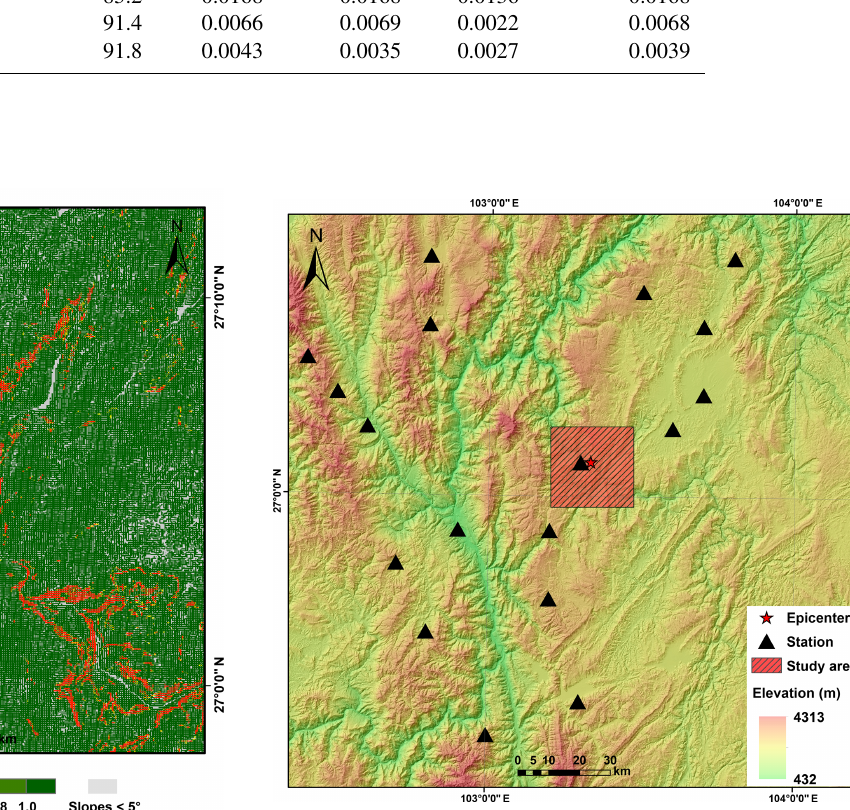
Figure 13. Map showing critical accelerations in the study area.